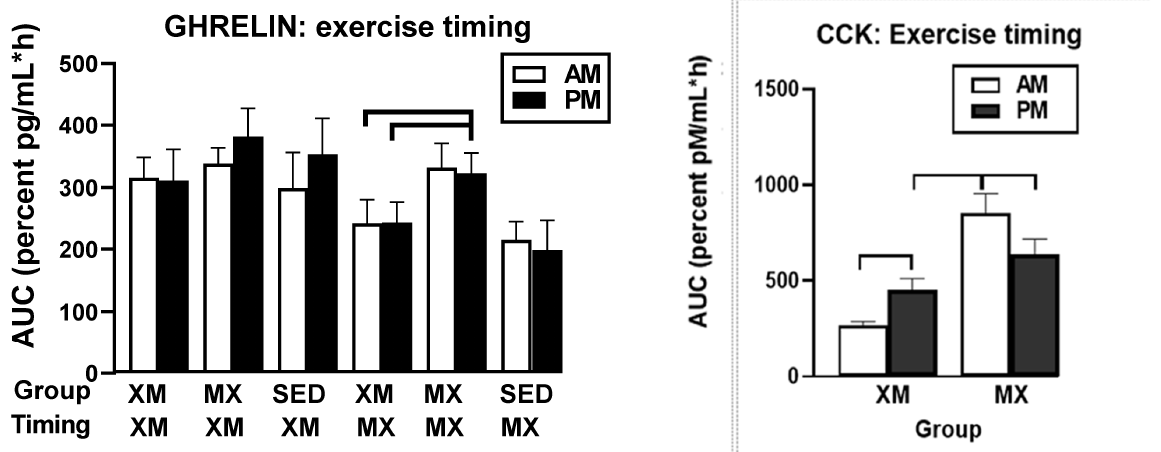
Figure 14. Exercise- and meal-timing effects on ghrelin and CCK AUCs. Brackets identify groups with significant between- and within-group differences. Afternoon MX ghrelin AUC was significantly higher than AM and PM XM AUCs ( left panel). Morning MX CCK AUC was significantly higher than PM XM AUC ( right panel). Both XM and MX CCK trials had significant within-group AUC differences. EX = exercise, XM = exercise before meals, MX-exercise after meals, SED = sedentary group.